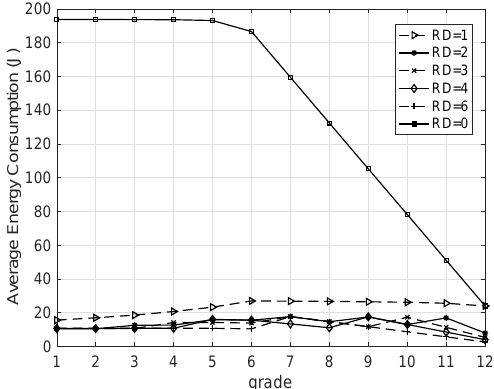
Figure 8. Average energy consumption versus grade.